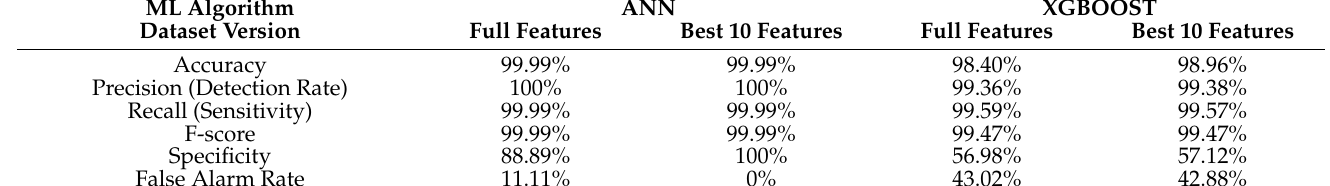
Table 4. The performance analysis of FIDChain using ANN compared to XGBoost with BoT-IoT dataset.